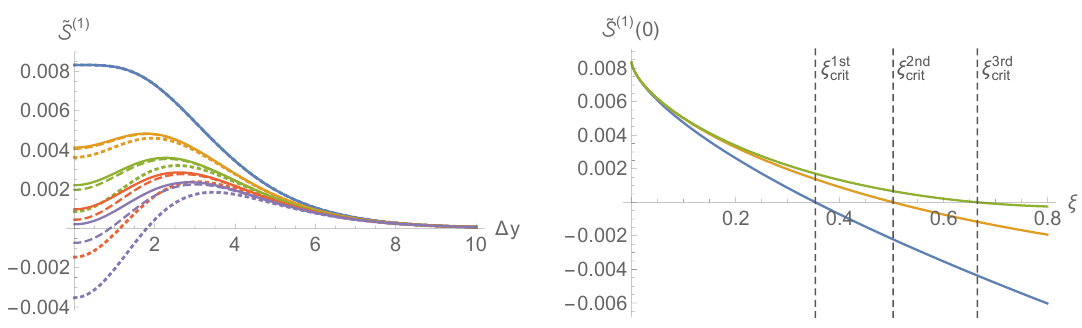
Figure 2 . Left: plots for ~ S (1) (cid:17) S (1) (cid:28) 4 = 3 =w 4 (cid:1) x 4 for various values of (cid:24) = (cid:28) (cid:0) 1 w (cid:0) 3 = 2 = 3 0 0 f 0 ; 0 : 15 ; 0 : 3 ; 0 : 45 ; 0 : 6 g depicted in blue, orange, green, red and purple, respectively. The solid lines correspond to third-order hydrodynamics; the dashed and dotted lines correspond to second- and (cid:12)rst-order hydrodynamics, respectively. Right: plots for ~ S (1) (0) for (cid:12)rst-, second- and third-order hydrodynamics, depicted in blue, orange and green, respectively. The dashed vertical lines corre- spond to the critical times at each order in